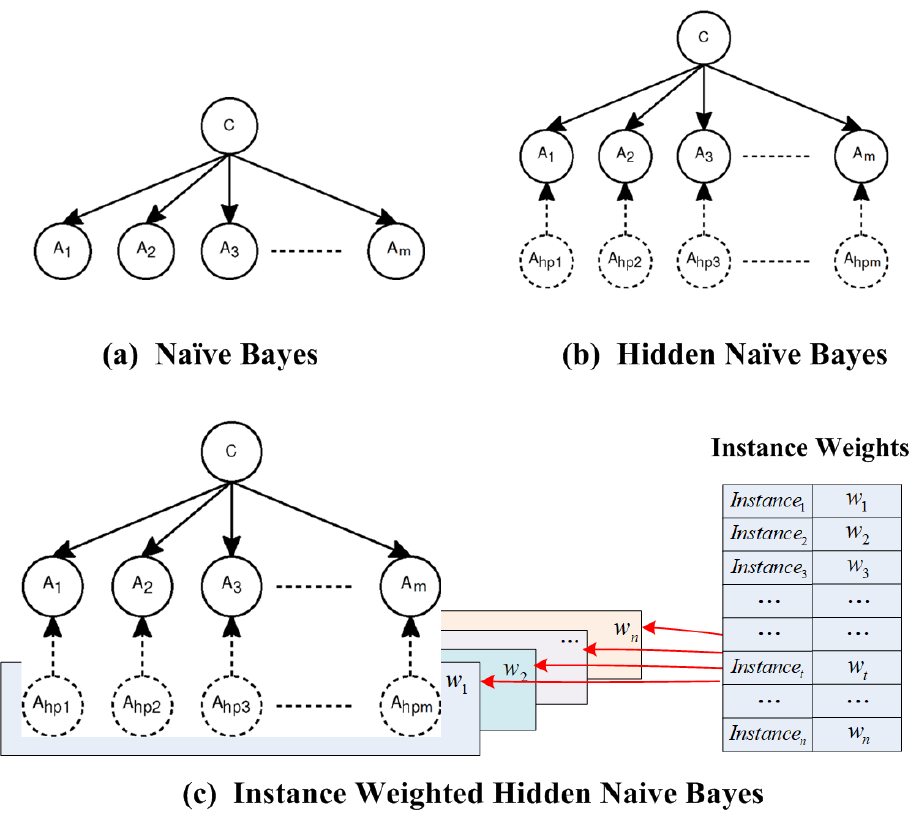
Figure 1. The different structures of related